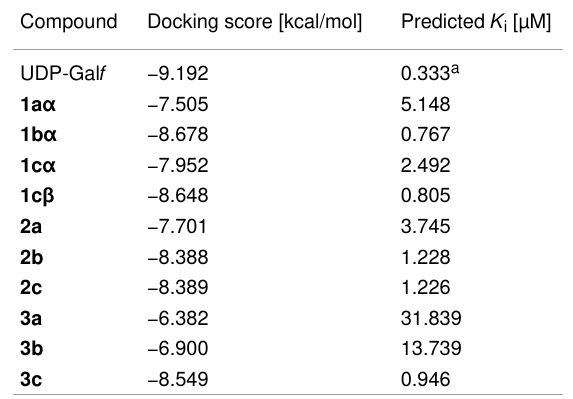
Table 1: Observed docking score and predicted K i values of the docked compounds 1 ‒ 3 .